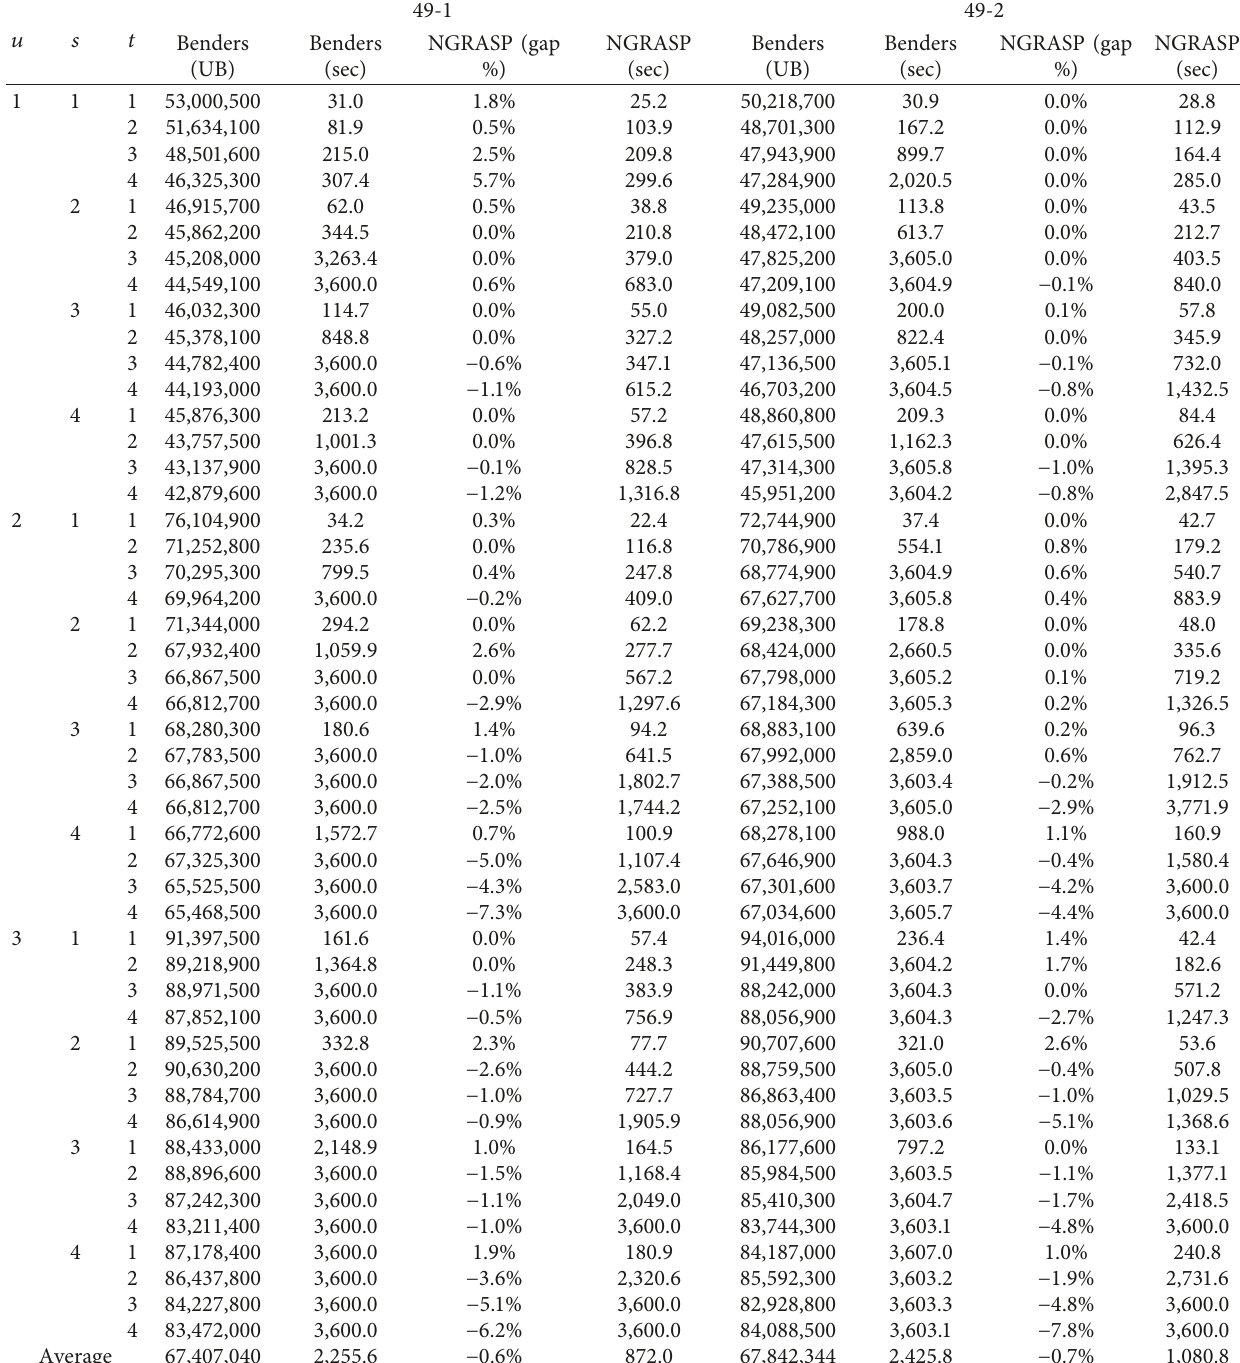
Table 9: Computational results on 49-node